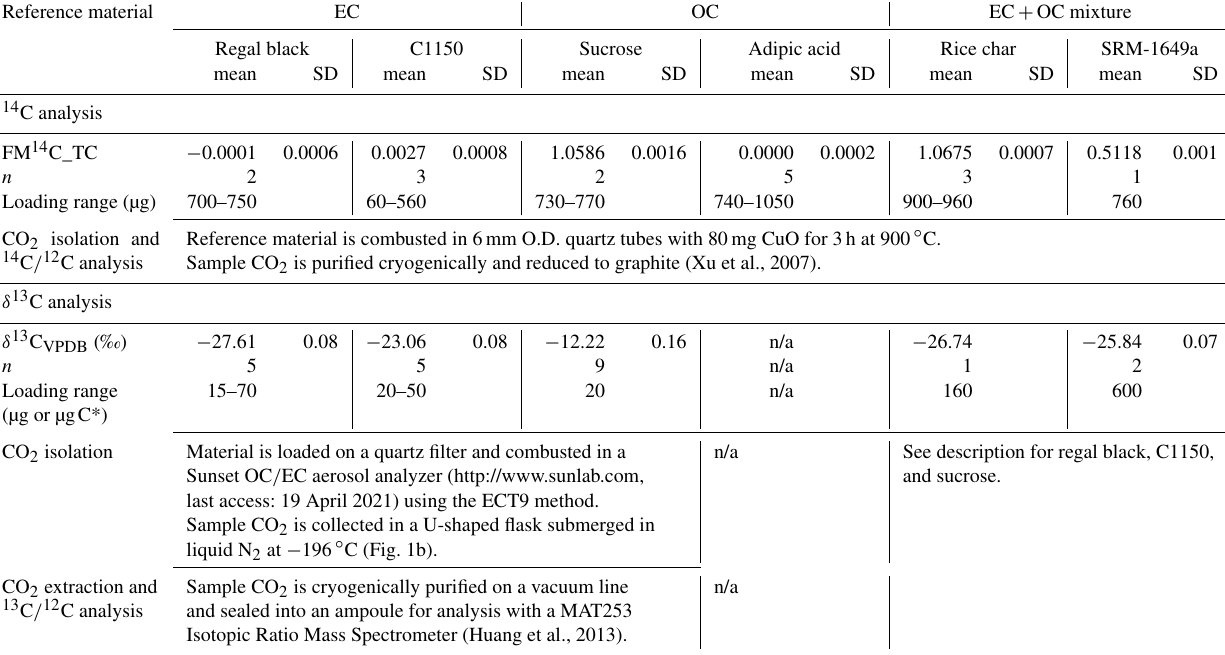
Table 2. Overview of the isotopic composition of the reference materials used in this study. Radiocarbon ( 14 C / 12 C, reported as fraction modern, FM 14 C) was measured at the KCCAMS facility, and δ 13 C was measured at the CAIR lab. Reference material